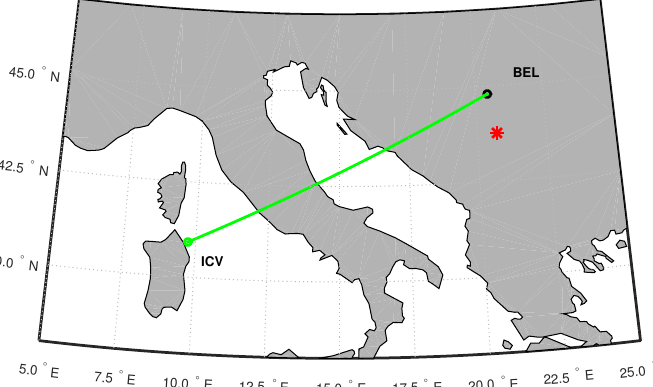
Figure 1. Propagation path of the VLF signal recorded by the Belgrade receiver station (BEL) in Serbia and emitted by the ICV transmitter in Isola di Tavolara, Sardinia, Italy (solid line). The location of the Kraljevo earthquake epicenter is shown as a